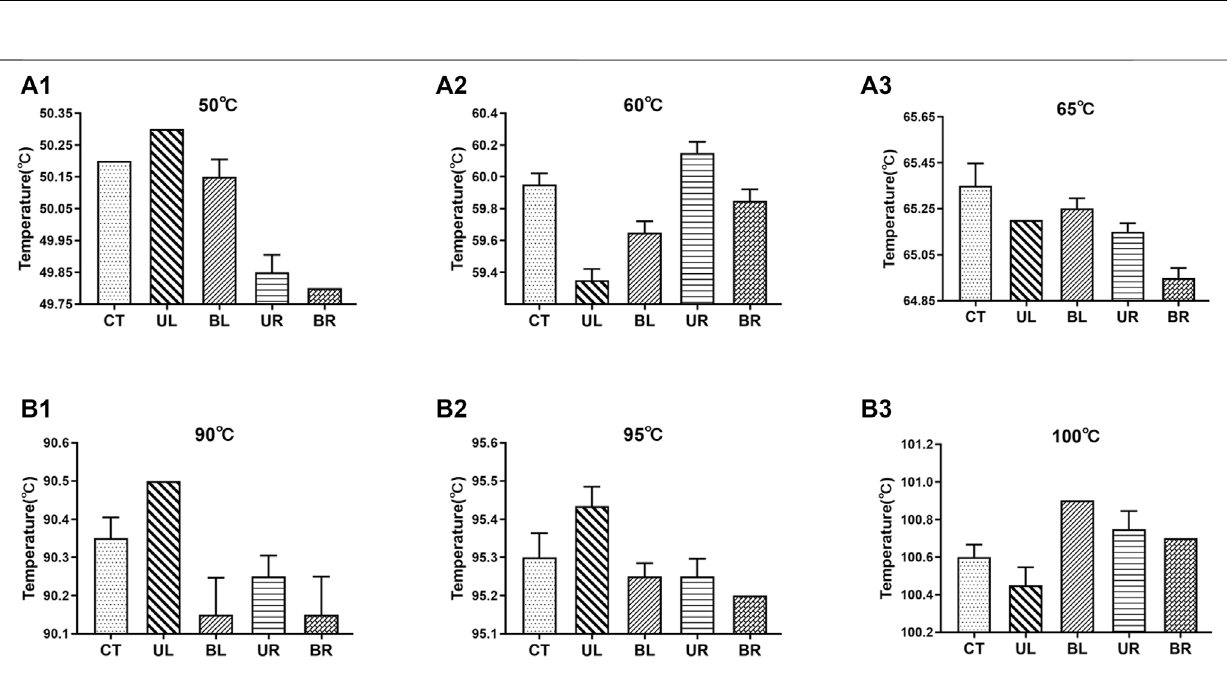
FIGURE1| Imageofthebasiccomponents ofCQ100 device: (A) dual temperature modules and (B) micro fl uidicchip.Thechip circulates back and forthbetween the module “ A ” and module “ B ” to perform the PCR. The target temperature of the module “ A ” was set to 50 ° C, 60 ° C, and 65 ° C, and the module “ B ” was set to 90 ° C, 95 ° C, and 100 ° C. (C) the matching chip holder.